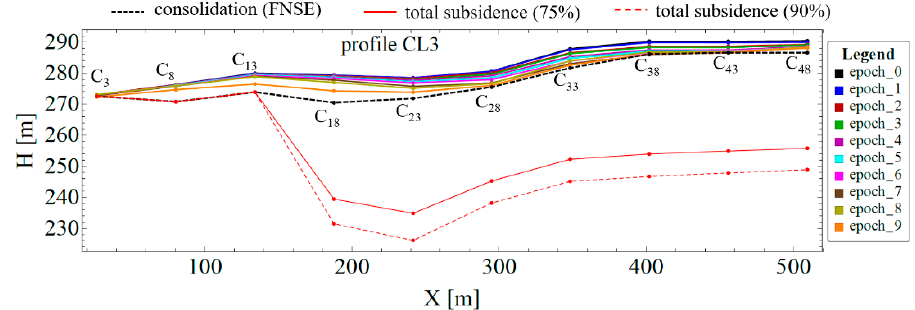
Figure 14. Calculated centroid height by profile CL3, including height at predicted consolidation (FNSE) and determined 75% or 90% total subsidence.